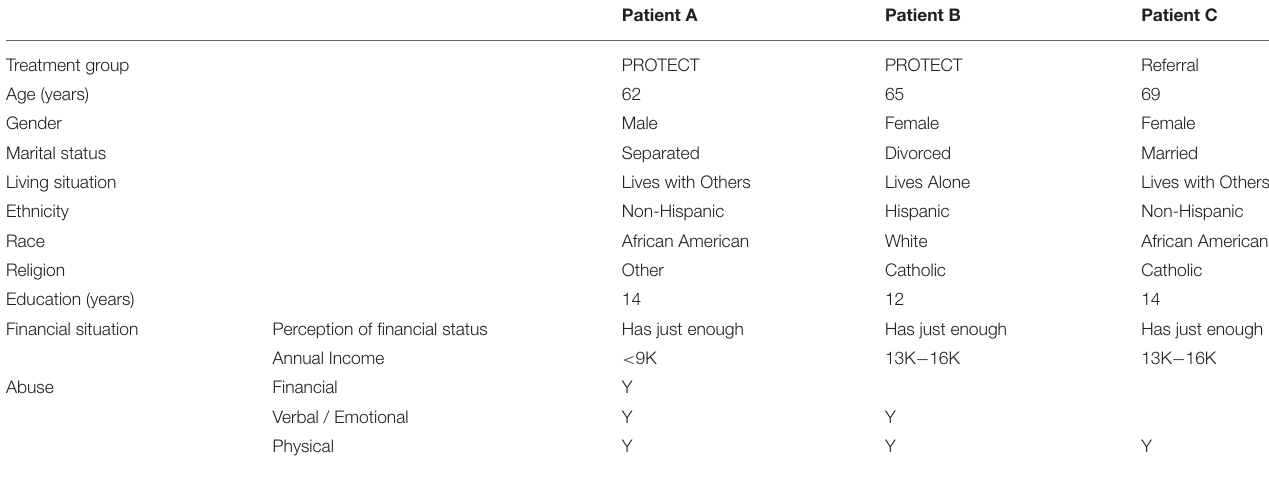
TABLE 1 | Demographic and clinical characteristics of the